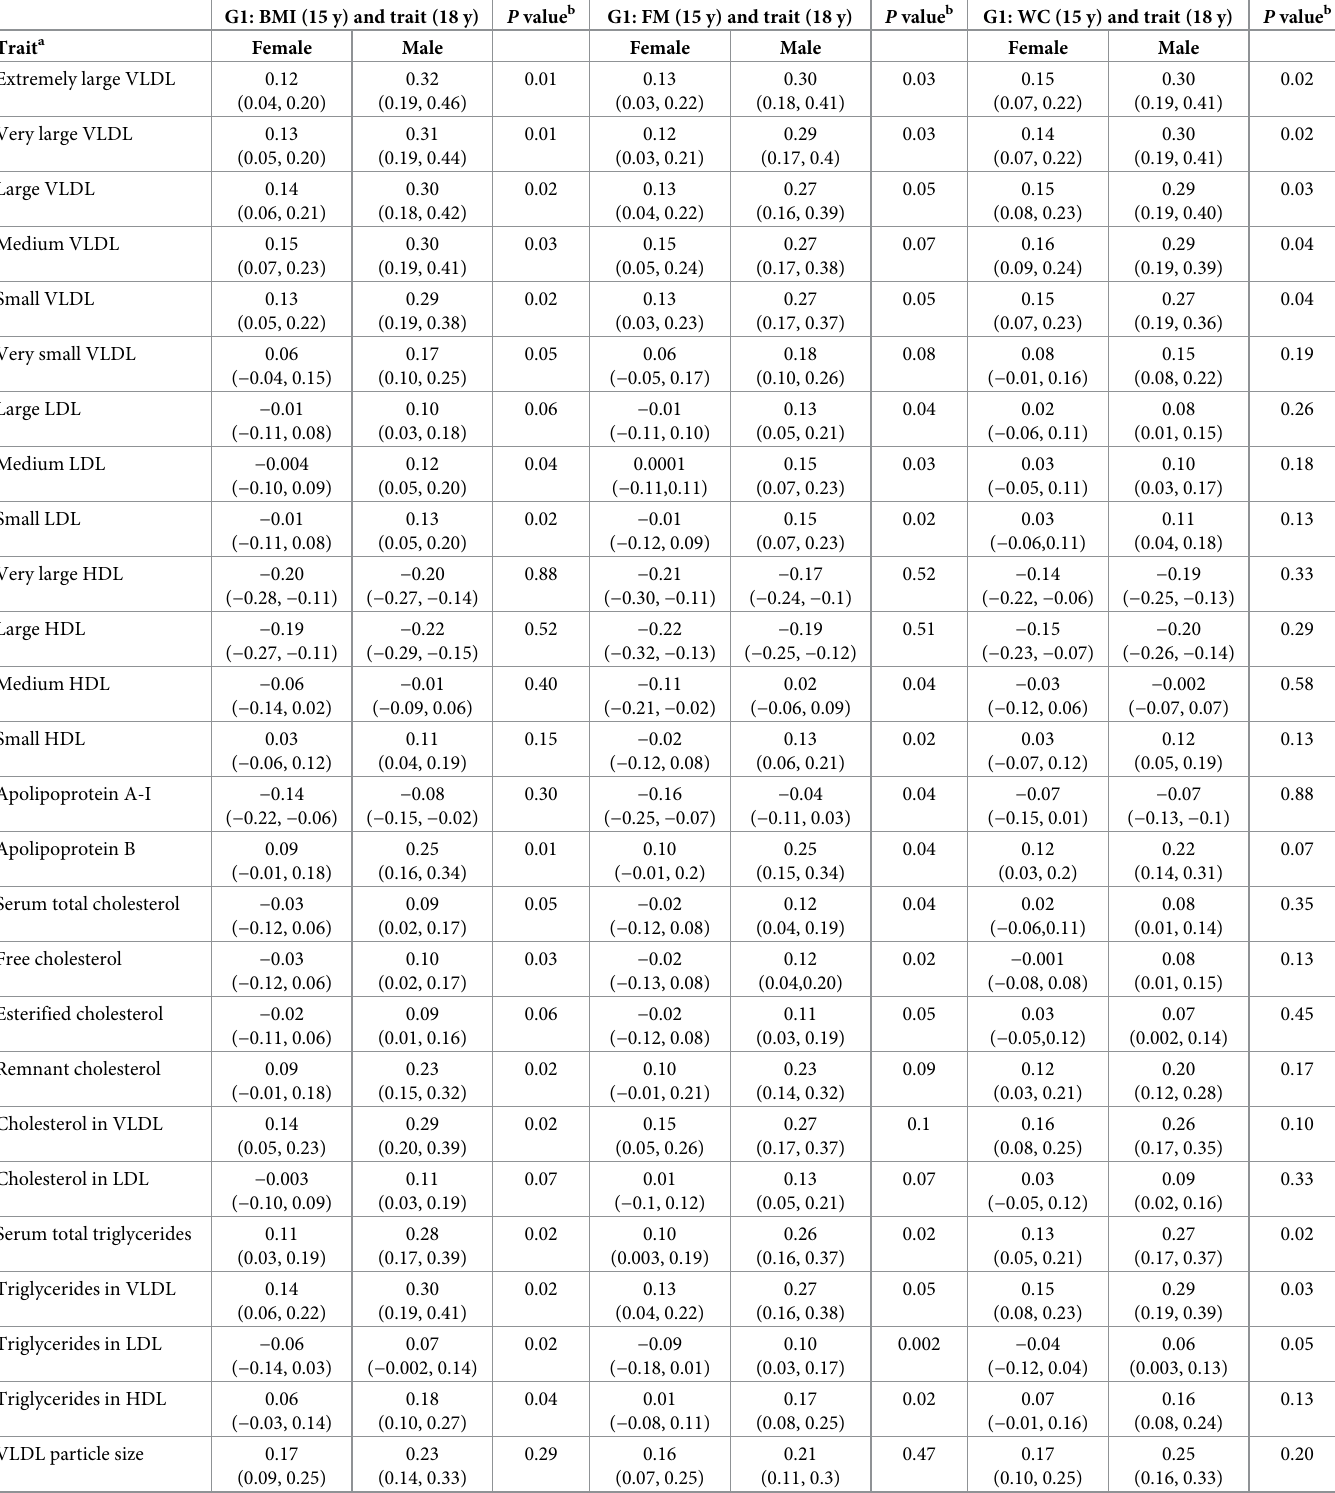
Table 3. Adjusted sex-specific associations of adiposity measures (per SD increase) at 15 y with standardised lipoprotein, cholesterol, triglyceride, and other trait concentrations at 18 y. G1: BMI (15 y) and trait (18 y) Extremely large